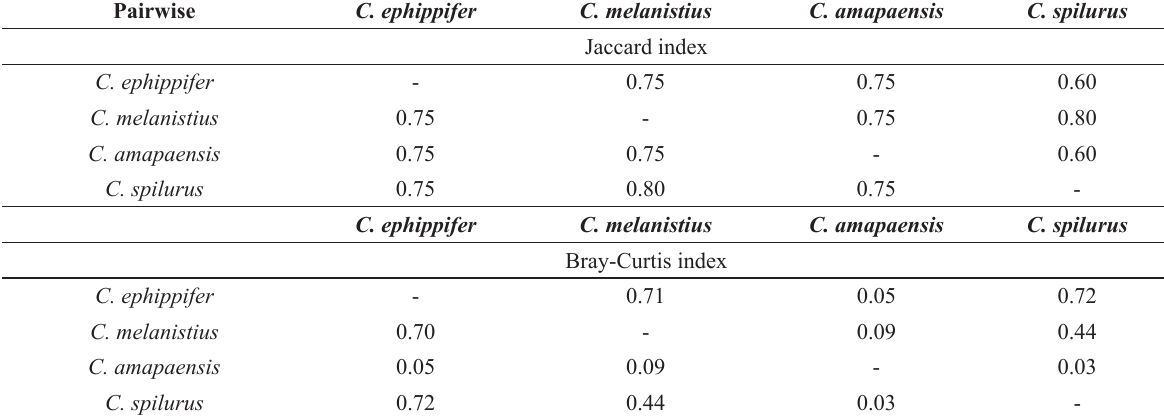
Pairwise similarity index of parasite component community in four species of Corydoras endemic to the eastern Amazon